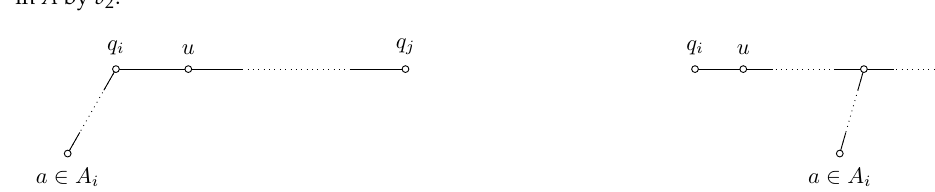
Figure 4. Construction of representative set A for q from representative sets A 1 = A 2 = b 1 , . . . , b h . The algorithm in the text considers three different cases depicted from left to right. { }